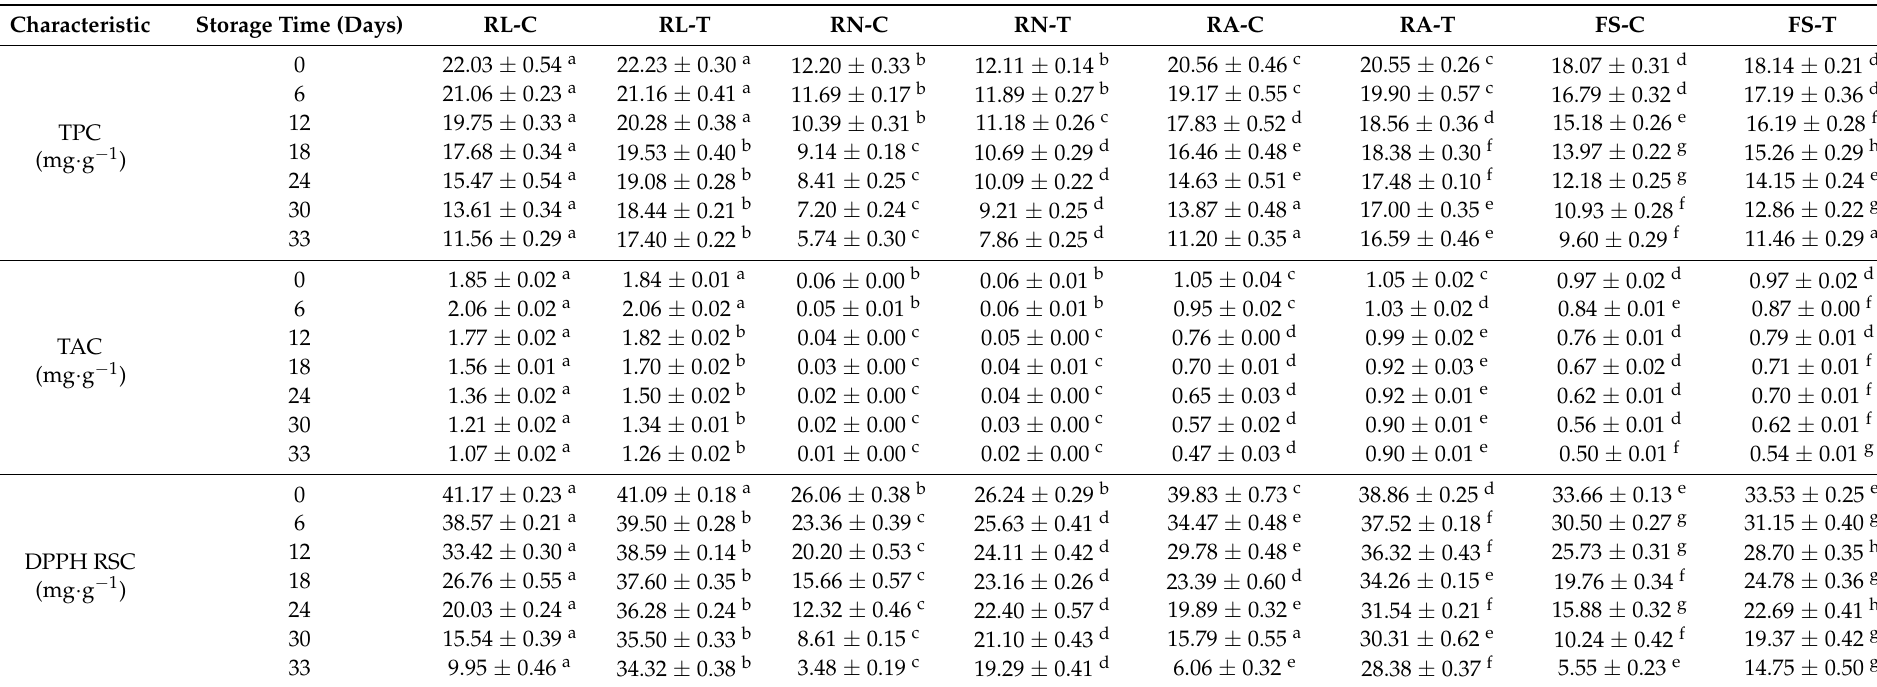
Data are mean ± standard deviation of three replicate samples. Different letters in the same row indicate significantly different values according to one-way ANOVA followed by Duncan’s multiple test range ( p <